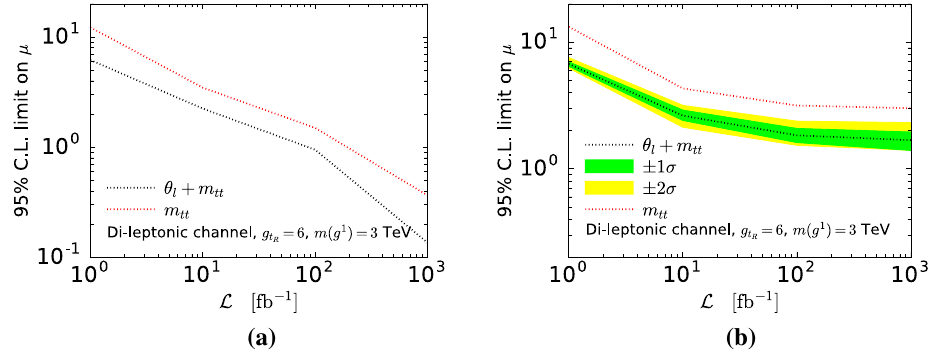
= 6) g 1 assuming a no system- Fig. 7 Limits on μ for a wide ( g t ( black line ) and only using m ( t ¯ t ) ( red line ) with the di-leptonic analy- R atics and b 5% systematics on the total cross section (see text for sis. The ± σ bands are for the combined result. μ = 1 corresponds to σ × Br ( g 1 → t ¯ t ) = 200 fb details on how this is propagated to the individual bins) which can be set with different assumed total luminosities using m ( t ¯ t ) and cos θ l ±